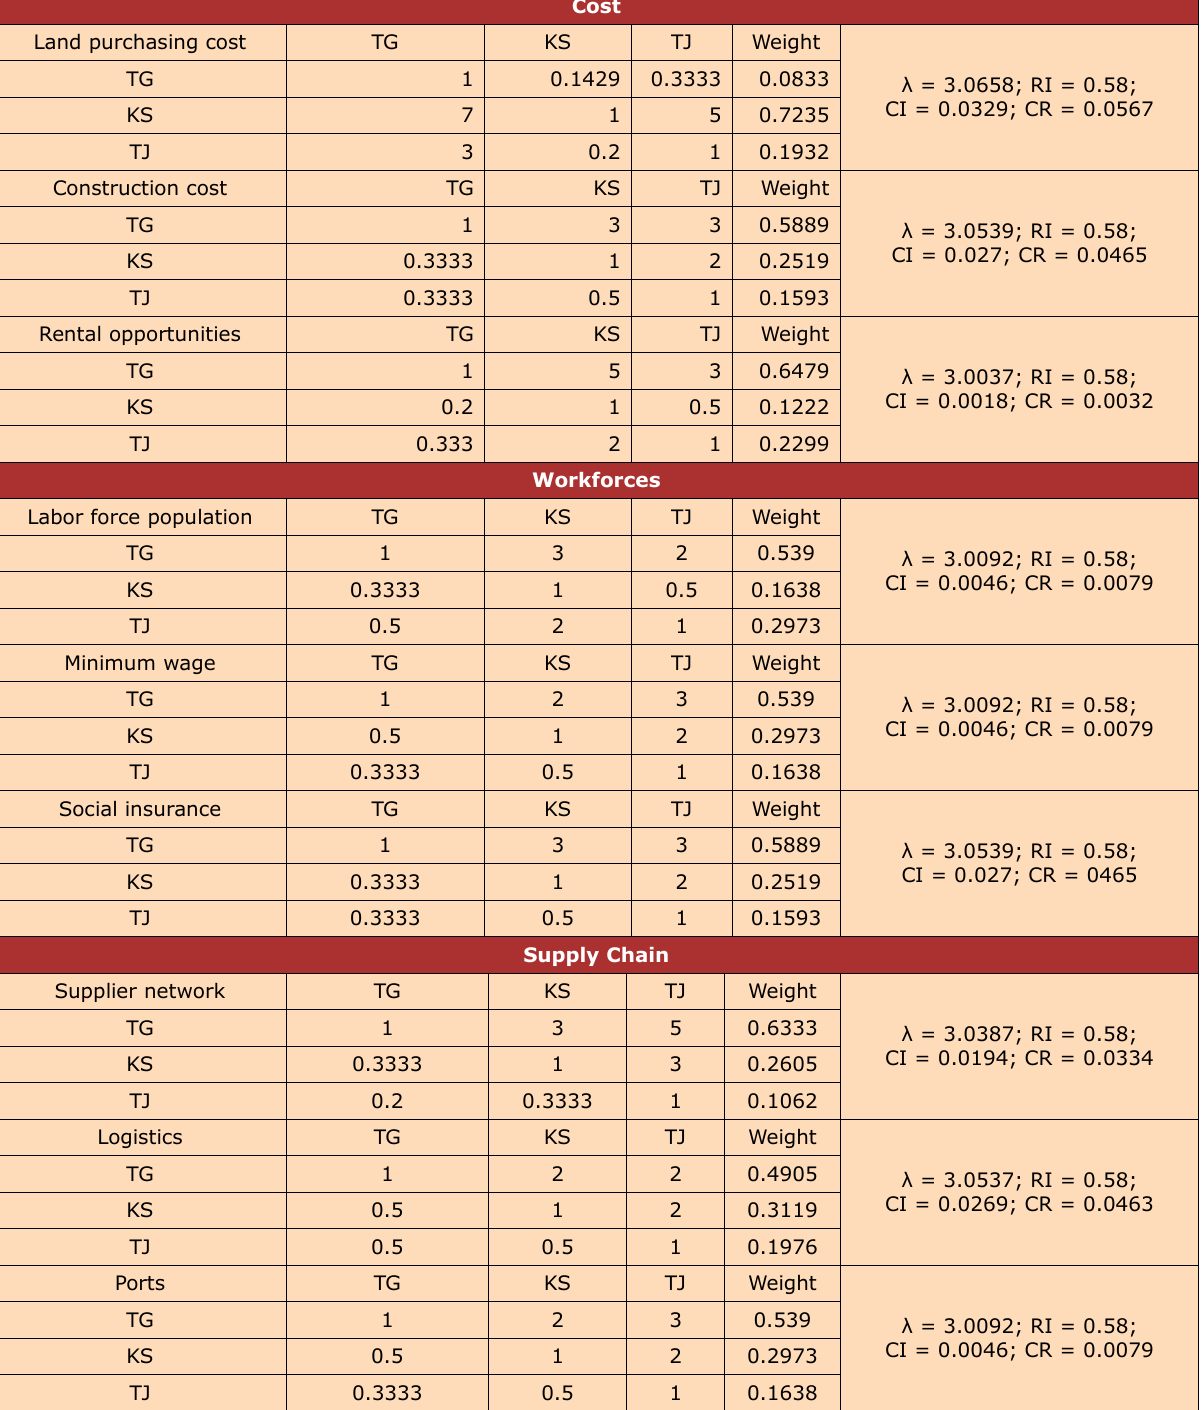
Table 5. Pair-wise comparison matrix among alternatives for subcriteria under cost,